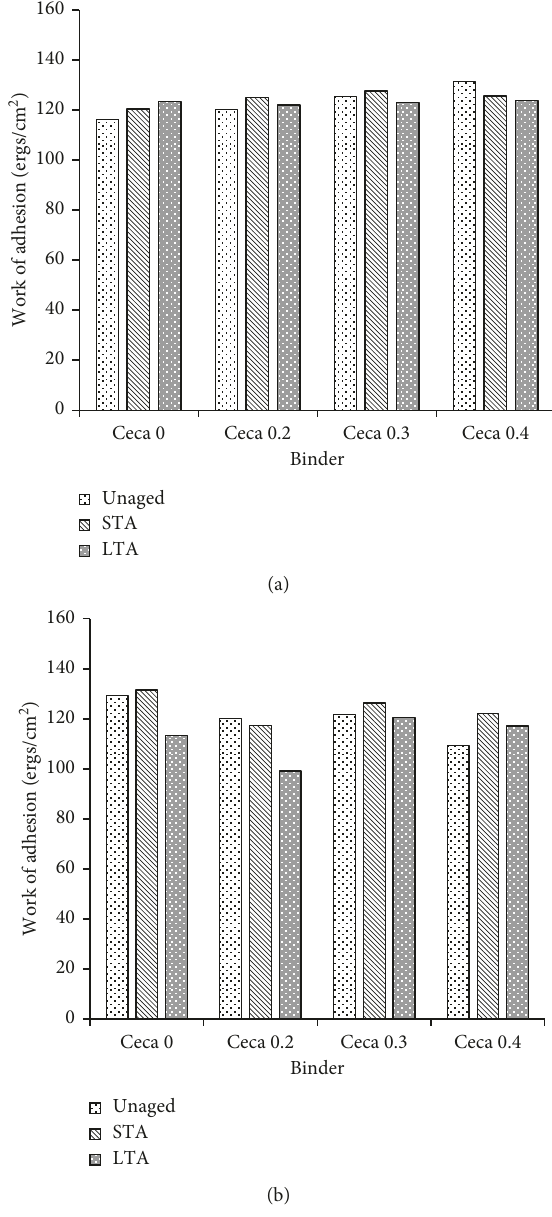
Figure 8: Work of adhesion energy of PG-64 asphalt binder: (a) limestone; (b)